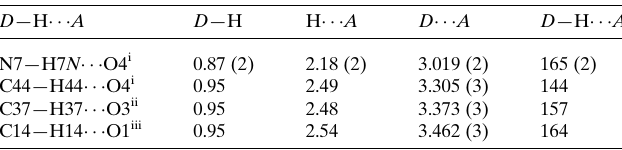
Table 2 Hydrogen-bond geometry (A˚ , (cid:2) ).